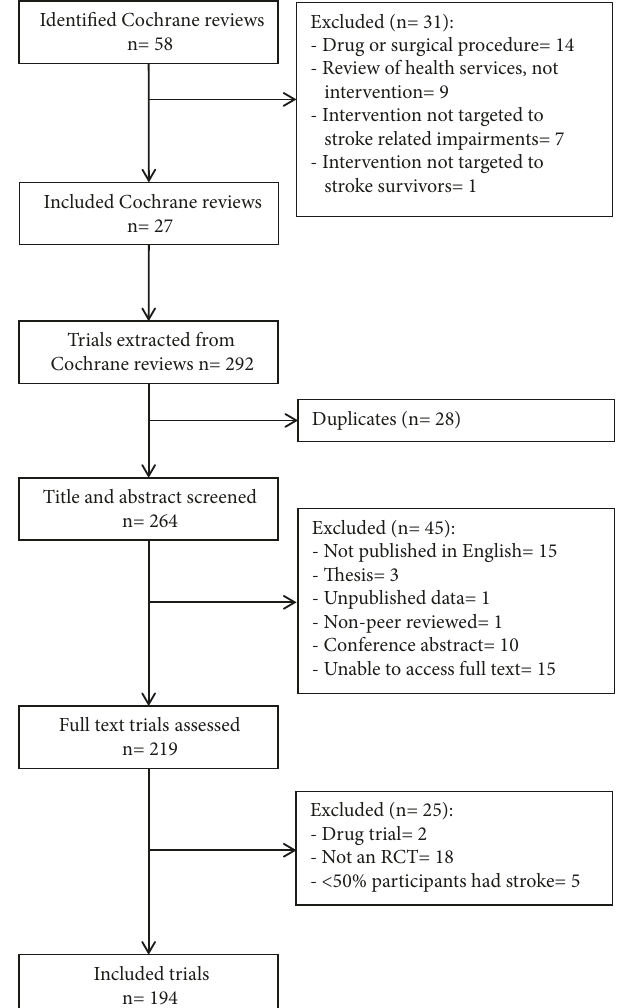
Figure 1: Flow diagram of identification and inclusion of Cochrane reviews and individual trials. Note . RCT= randomised controlled trial.